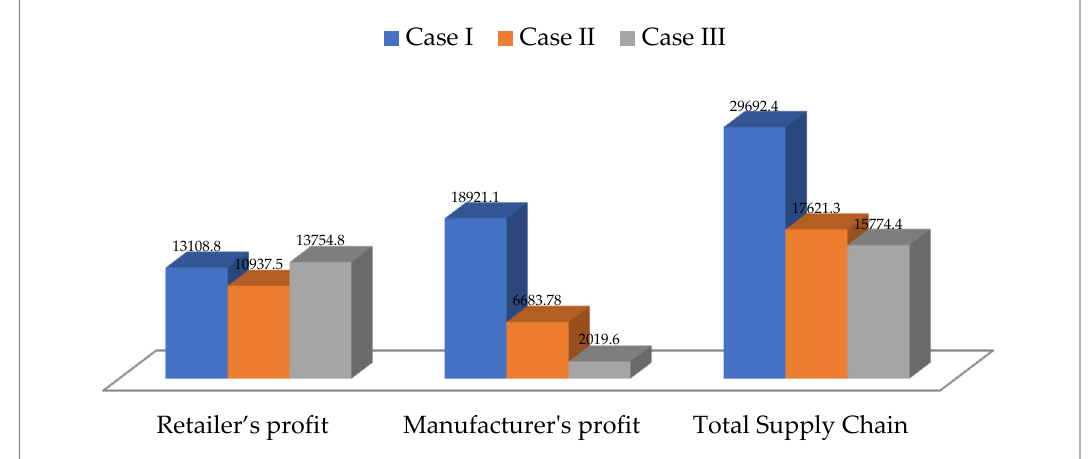
Figure 3. Mixture situation measures under three policies.